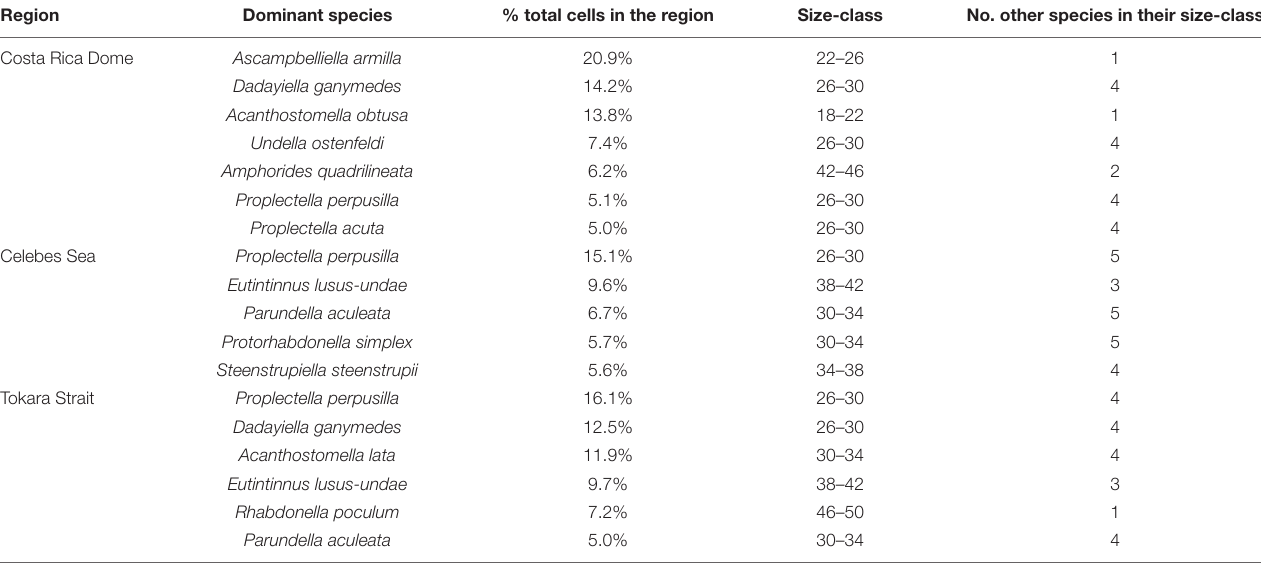
TABLE 2 | Identity and morphology of the dominant species in the assemblages. Region Dominant species % total cells in the region